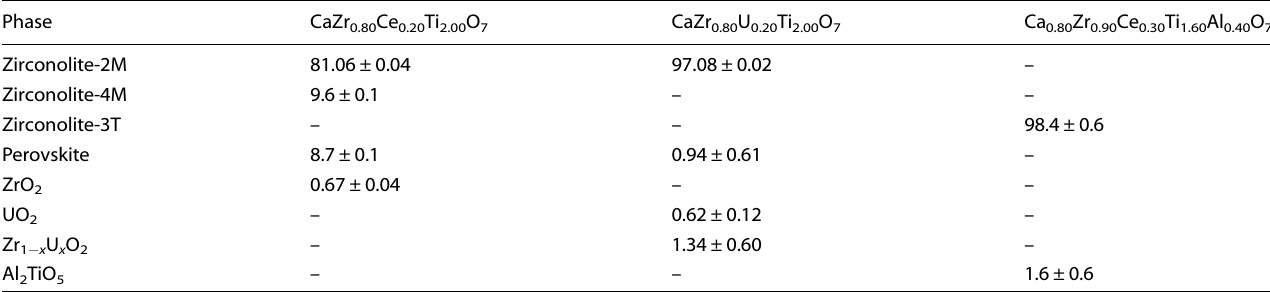
Table 1. Phase assemblage of zirconolite materials, as determined by Rietveld analysis of powder XRD data shown in Fig. 1.